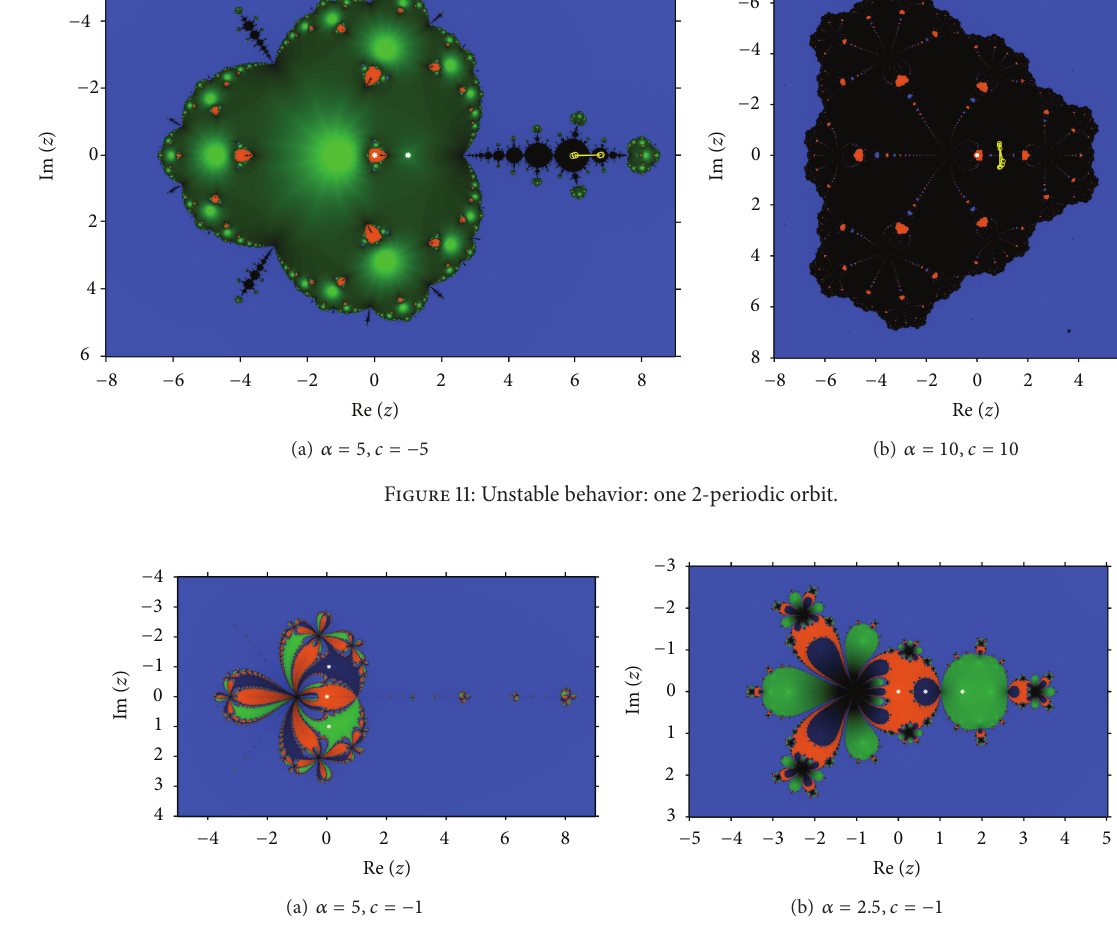
Figure 12: Unstable behavior: attracting strange fixed